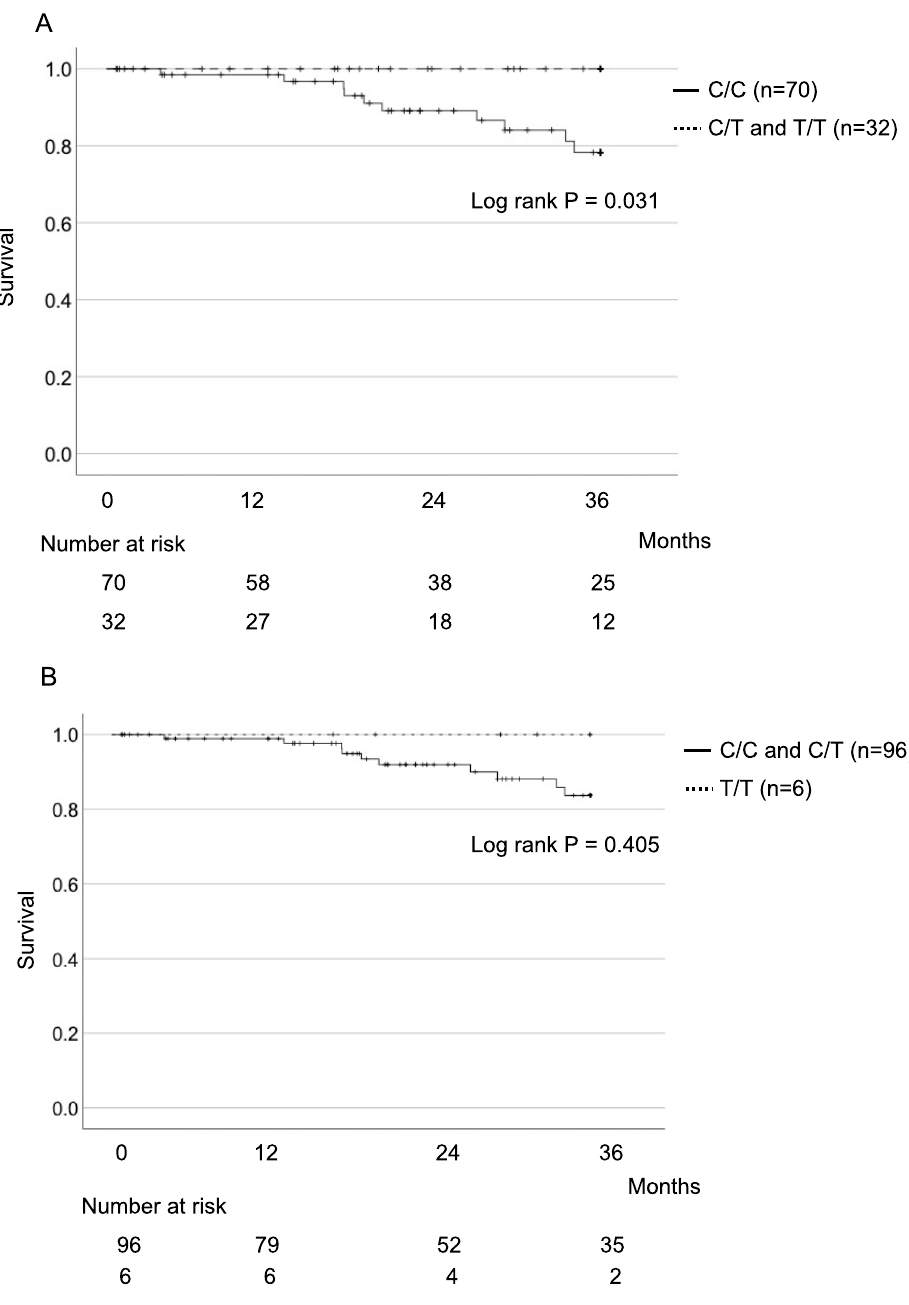
Figure 2. (A) Kaplan–Meier survival curves for carriers (n = 32) and non-carriers (n = 70) of the rs3750920 T allele. Carriers had significantly better survival at 3 years (P = 0.031). (B) Kaplan–Meier survival curves for carriers (n = 96) and non-carriers (n = 6) of the rs3750920 C